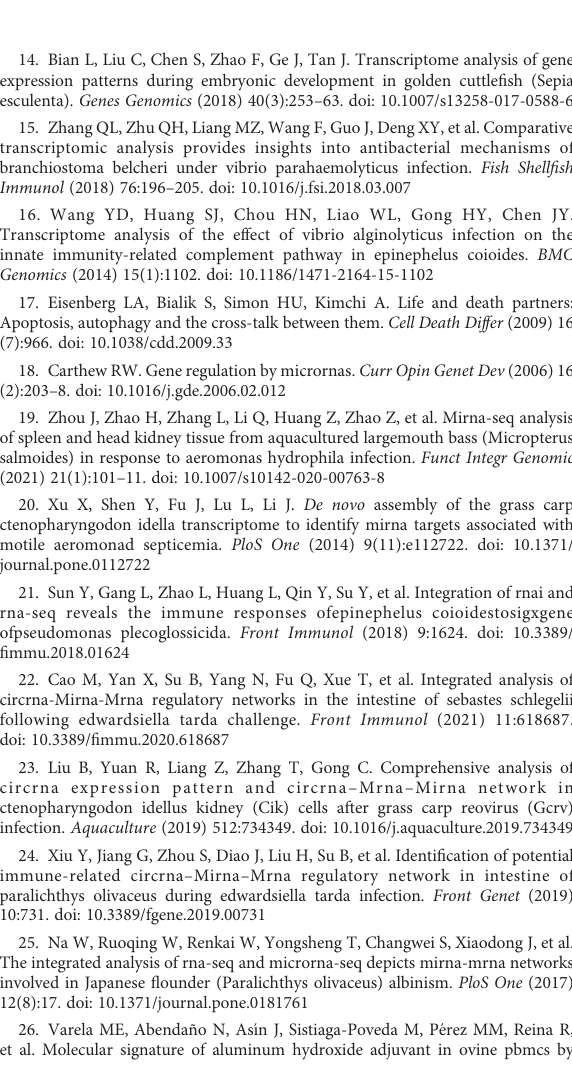
SUPPLEMENTARY FIGURE 1 Top 20GO termsof biologicalprogress category. Theabscissa represents the ratio of DEGs to all genes annotated to the given GO term and the vertical coordinate represents the GO terms. The redder bubble indicates more obvious enrichment, with smaller FDR. The larger bubble contains more differentially expressed genes. SUPPLEMENTARY FIGURE 2 Length distribution and abundance of small RNAs of the 6 libraries. (A – F) Length distribution and abundance of small RNAs from spleen of QC_1, QC_2, QC_3, QS_1, QS_2, QS_3, respectively. The abscissa represents the length of small RNAs, and the vertical coordinate represents the tag